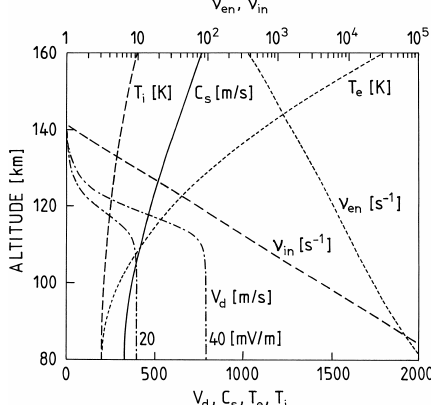
Figure 1. Altitude variation of collision frequencies, ν e , ν i , and tem- peratures T e , T i , together with the corresponding variation of the sound speed, with V d being the difference between the ion and elec- tron drift velocities calculated for E 0 = 20 and 40mVm − 1 . Note that the collisions frequencies have variable values at the top, while parameters like C s ,T e ,T i ,V d ≡ U e − U i have their values on the bottom axis. For the altitude range shown we can take the electron and ion cyclotron frequencies to be constant, ω ce = 9 . 5 × 10 6 and (cid:127) ci ≈ 170rads − 1 , respectively, with (cid:127) ci corresponding to an aver- age ion mass of